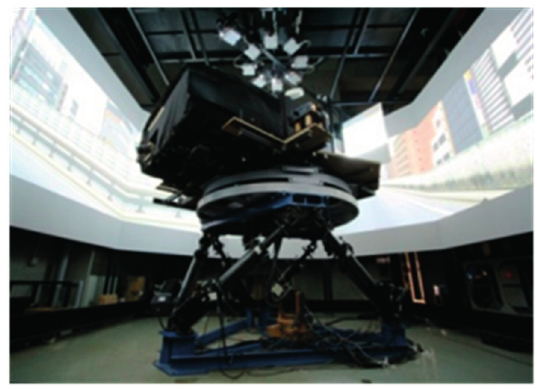
Figure 1. Photograph of the driving